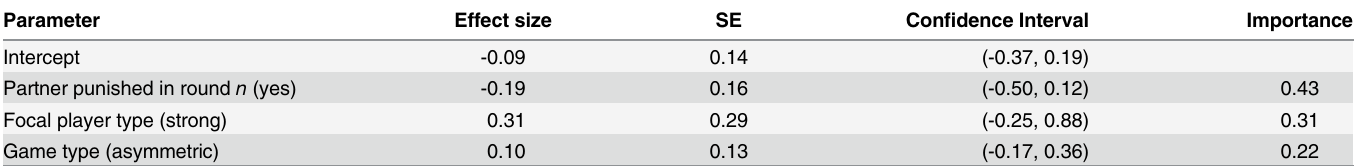
Table 5. Factors affecting whether players cooperated increased cooperation level.